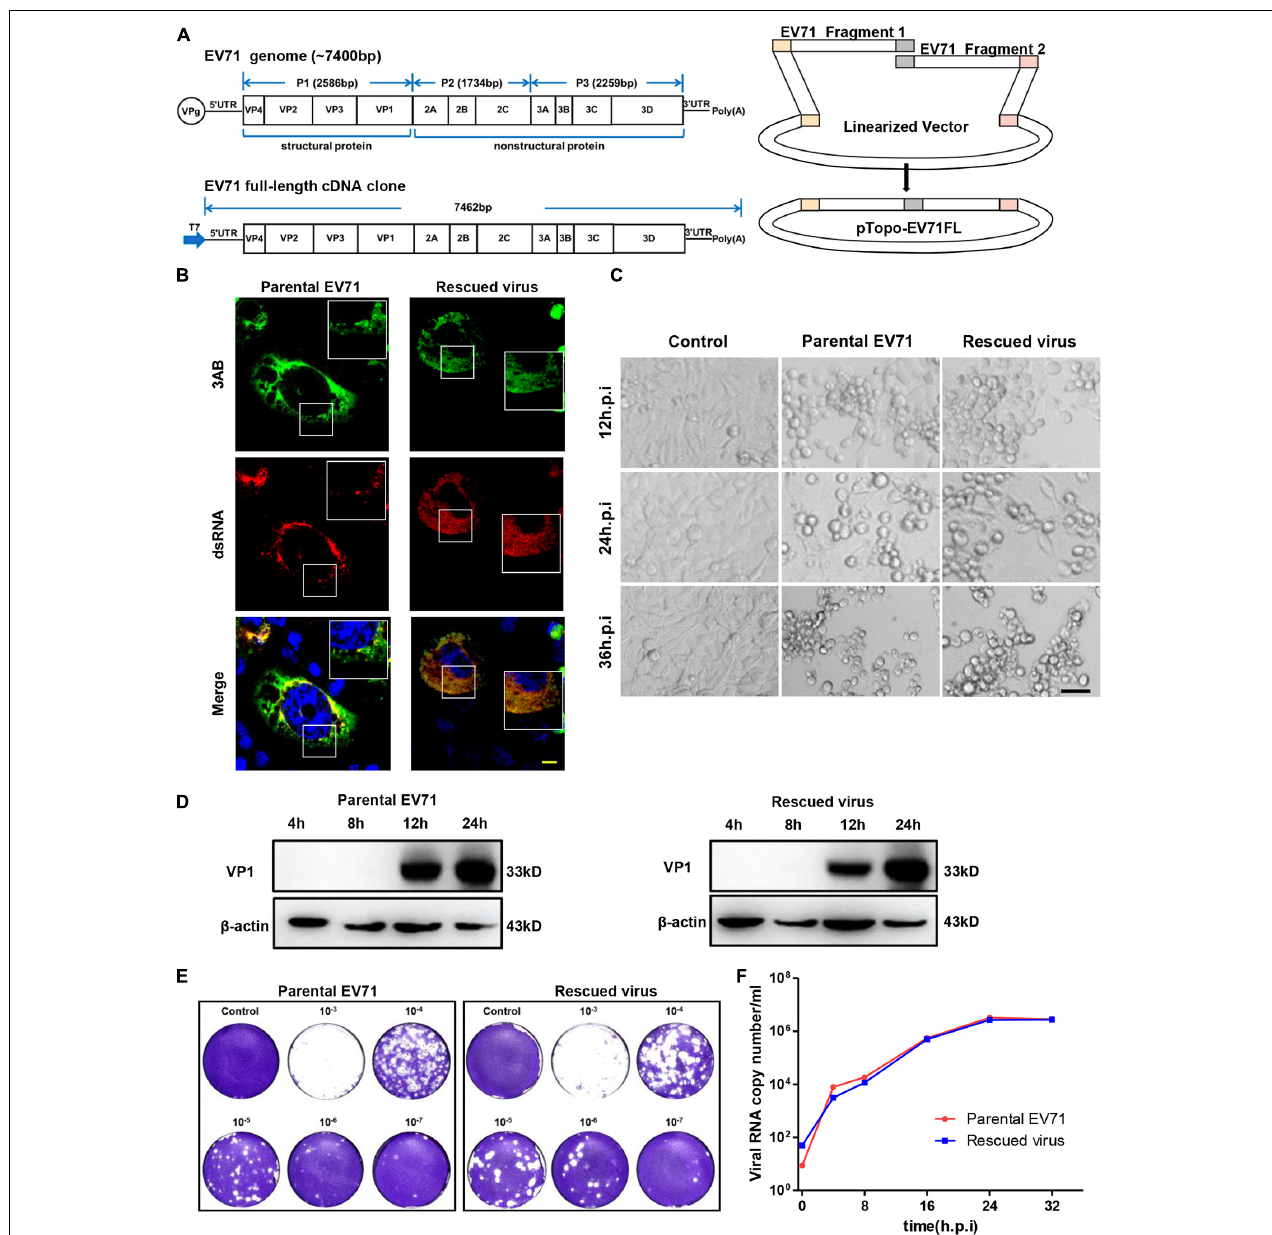
FIGURE 1 | Characterization of rescued EV71 infectious clone. (A) Diagrams showing the genome of EV71 and cloning strategy used to make full-length infectious clone. (B) RD cells infected with parental or rescued EV71 virus were immunostained with anti-3AB and anti-dsRNA antibody. Nuclei were counterstained by DAPI. Bar, 10 µ m. (C) Uninfected or RD cells infected with parental or rescued EV71 virus were observed at indicated time points for cytopathic effect. Bar, 100 µ m. (D) RD cells infected with parental or rescued EV71 virus were immunoblotted with anti-VP1 antibody. β -actin was used as a loading control. (E) RD cells infected with serial dilutions of parental or rescued EV71 virus were analyzed by plaque assay. (F) Viral RNAs from RD cells infected with parental or rescued EV71 virus were quantitated by q-RT-PCR at various time points to compare the replication kinetics of these two